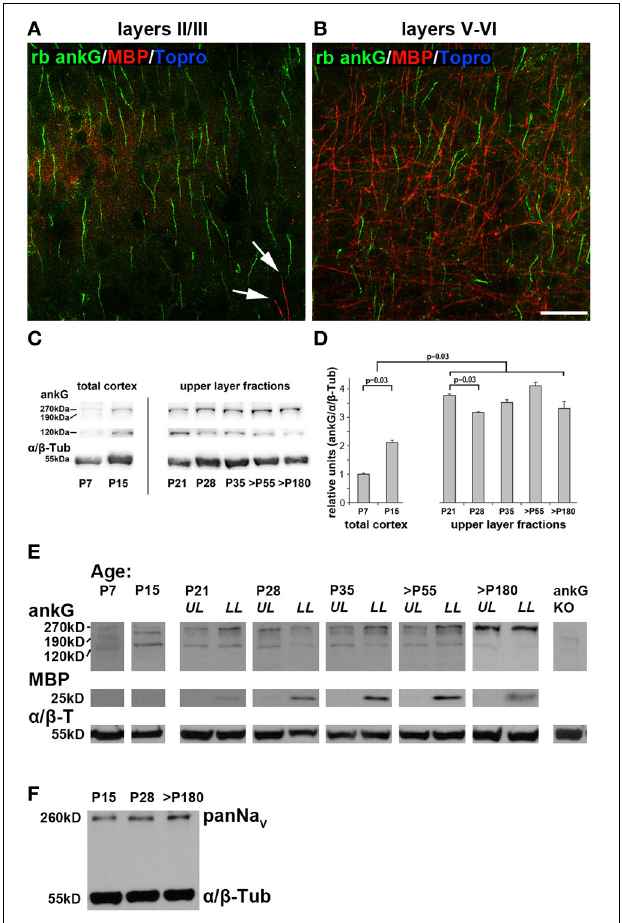
FIGURE 5 | AnkG, myelin and voltage-gated sodium channels (panNaV) protein expression during AIS development in visual cortex. (A) Myelin distribution in layers II/III in an adult mouse (P67) with ankG (green) and myelin basic protein (MBP, red). MBP immunosignals were only rarely observed (arrows). (B) Myelin distribution in layers V and VI in the same section as (A) . MBP is more evident in infragranular than supragranular layers. (C) Representative immunoblot bands for ankG and α / β tubulin in total cortex samples from P7 and P15, and upper layer lysates from P21 through > P180 ages. (D) Quantification of ankG expression at various time points during development. P7 and P15 bars represent total visual cortex lysates, ages P21 and older the upper layer fractions only. AnkG protein was normalized to the internal loading control ( α / β Tubulin) and levels are expressed relative to the normalized ankG expression at P7, which was set to 1. Shown are bars with standard deviation from three replicates. AnkG expression increased significantly during postnatal development (P7–21). From P21 to 28, coinciding with the maximum of length reduction ( Figure 3A ), ankG protein was reduced. However, despite significant re-elongation of the AIS past P28 ( Figure 3A ), no significant changes in protein amount were detected ( p ≥ 0 . 05). (E) Representative immunoblot bands for ankG, MBP, and α / β tubulin in various age samples from P21 through > P180 were separated for upper and lower cortical layers (UL, upper layers; LL, lower layers). P7 and P15 samples were obtained from whole visual cortex lysates. MBP first appeared around P21. Far right lane shows immunoblot from a cerebellar ankG knockout mouse confirming specificity of rabbit anti ankG antibody. (F) PanNa V immunoblot from the three stages of the tri-phasic AIS length development shows constant levels for sodium channel expression despite significant AIS length changes ( Figure 3A ). Scale bars (A,B) = 25 μ